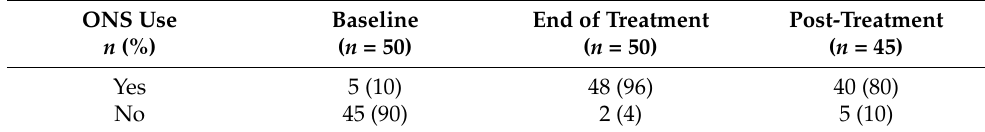
Abbreviations: ONS: oral nutrition